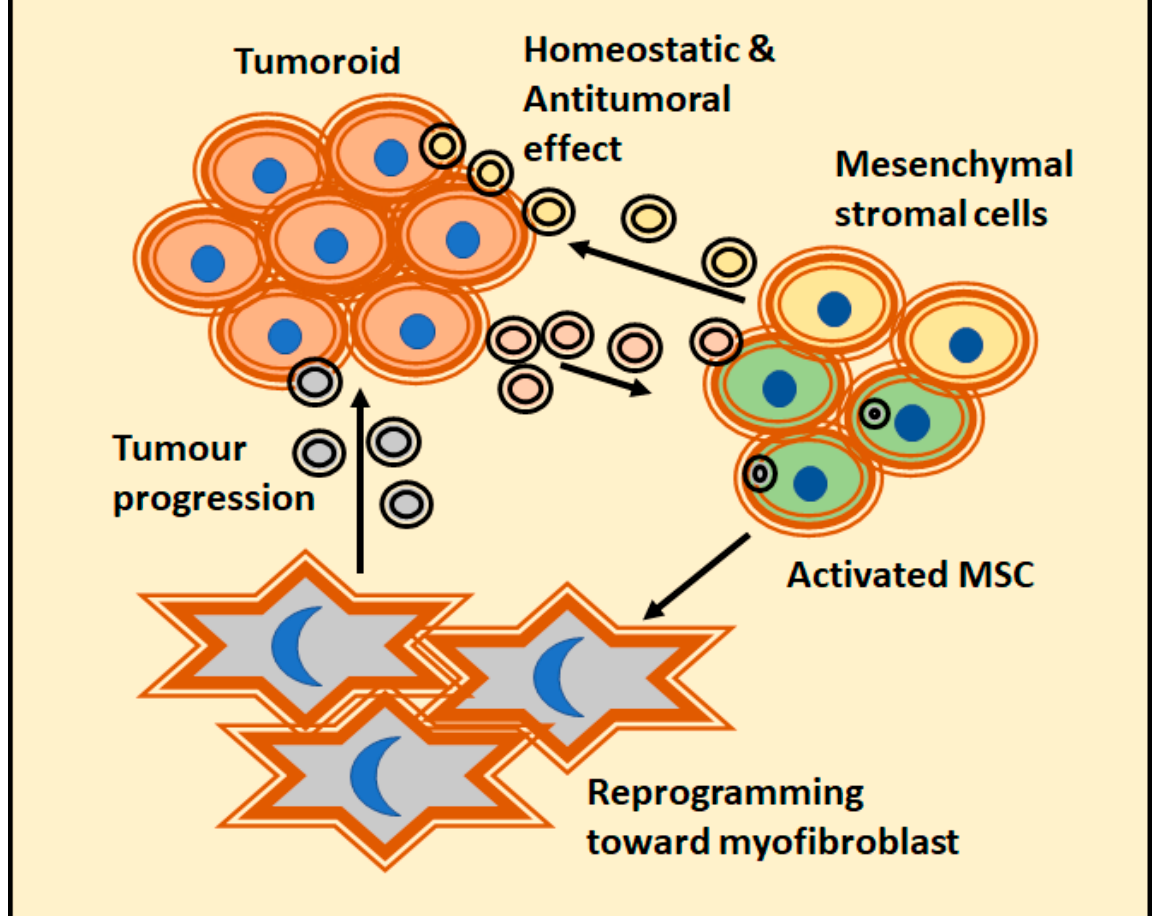
Figure 3. A clear example of tumor-matrix interaction was provided by the prostate cancer models and their action over mesenchymal stroma cells (MSCs). It is a complex relationship were EVs released by tumors could change the fate of MSC. While MSC-derived EVs have a homeostatic effect, activated MSCs usually reprogram themselves into myofibroblast and actively favor tumor progression.